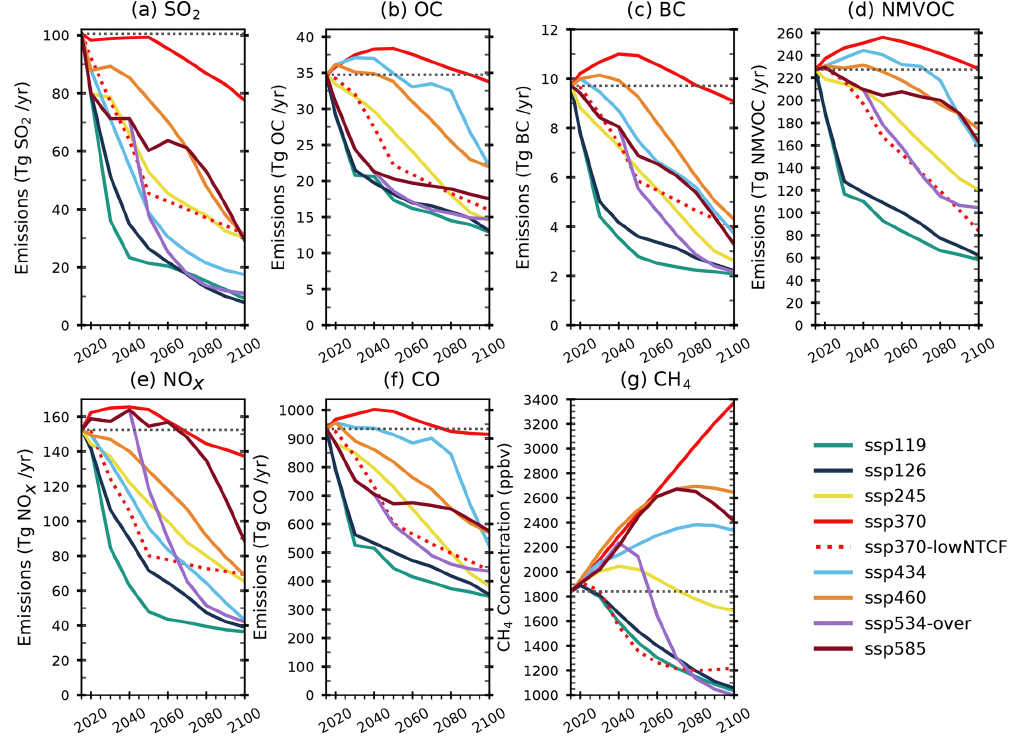
Figure 1. Changes in annual total (anthropogenic and biomass) global air pollutant emissions (relative to 2015) of sulphur dioxide (SO 2 ), organic carbon (OC), black carbon (BC), non-methane volatile organic compounds (NMVOCs), nitrogen oxides (NO x ), carbon monoxide (CO) and global methane (CH 4 ) abundances in the future CMIP6 scenarios used as input to CMIP6 models. The dashed black line represents the 2015 value. Global CH 4 abundances are not reduced in the AerChemMIP ssp370-lowNTCF simulations used